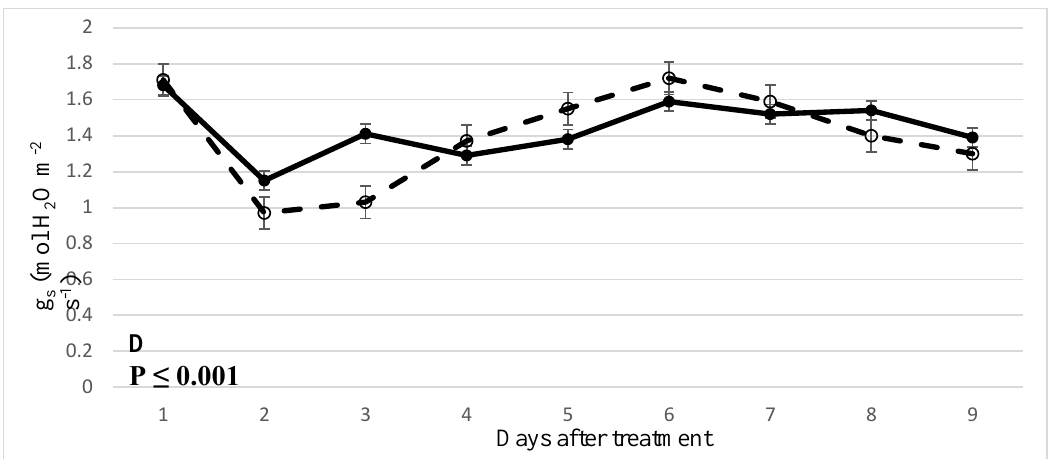
Figure 1. The effect of waterlogging on ( A ) net photosynthesis ( A ), ( B ) internal CO 2 (C i ), ( C ) transpiration ( E ), and ( D ) stomatal conductance (g s ) of cucumber plants in an early developmental stage of growth. Water was kept 10 cm above the container to simulate waterlogging stress. Data are from 10-day treatments of waterlogging (•) or non -waterlogging ( ○ ) treatments.